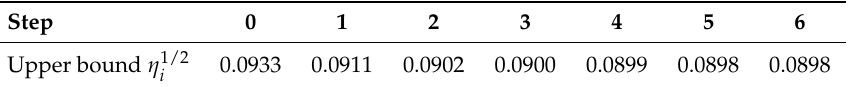
obtained in the steps i = 0, . . . i